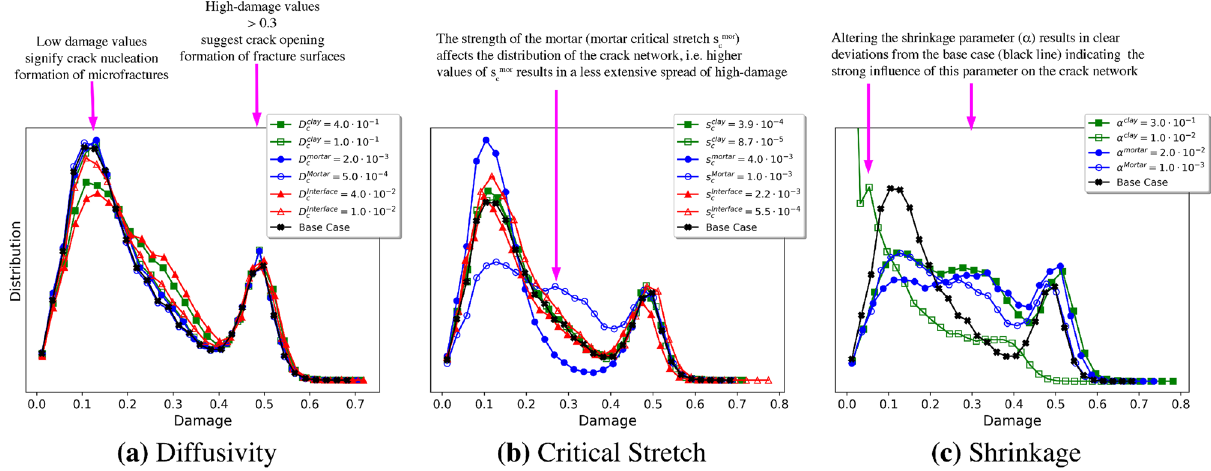
Figure 8. Histograms describing the distribution of damage among nodes in the numerical experiments after six (6) full days of dehydration. The bucket values on the x-axes are damage (see Equation (12) in Supplementary Note 12), which describes the number of broken bonds at a node. For example, 0.0 corresponds to no broken bonds and 0.6 corresponds to 60% of bonds at a node being broken. The y-axis provides the quantity of nodes which fall into each bucket. Many of the plots have two peaks, the first of which occurs for damage near 0.15 which likely corresponds to crack nucleation and the formation of microfractures; the second peak with damage near 0.5 is primarily from the formation of fracture surfaces, particularly due to debonding between the clay and mortar. From the histograms, it is clear the most sensitive parameters are the shrinkage of both the clay and mortar and the critical stretch of the mortar.